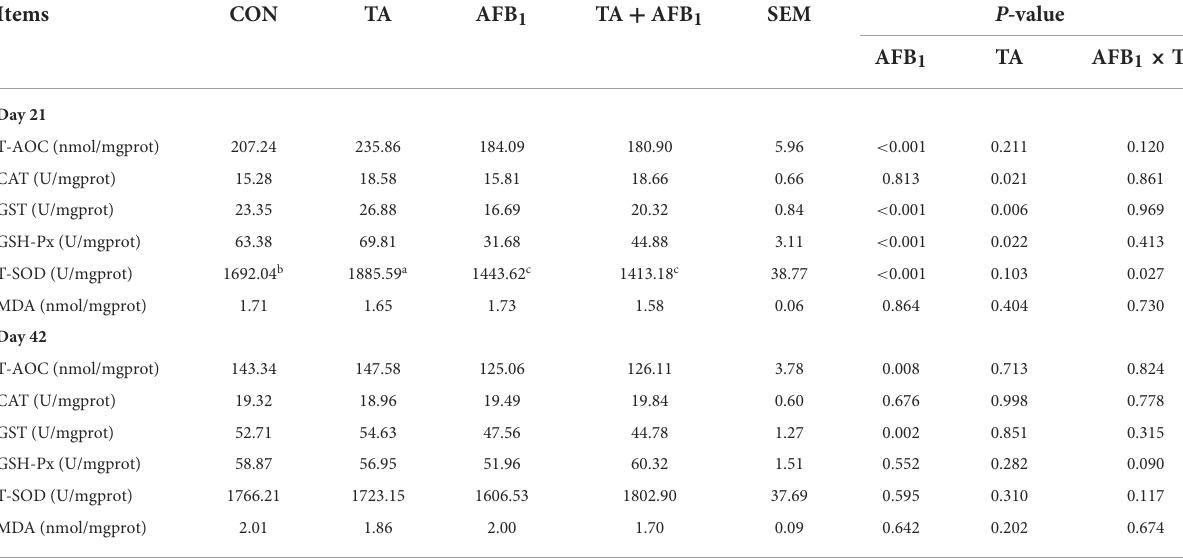
TABLE 6 Effects of tannic acid on liver antioxidant capacity of broilers challenged with AFB 1